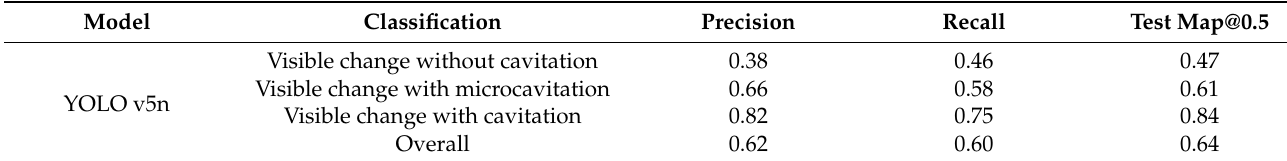
Table 2. YOLO network results obtained with test-time